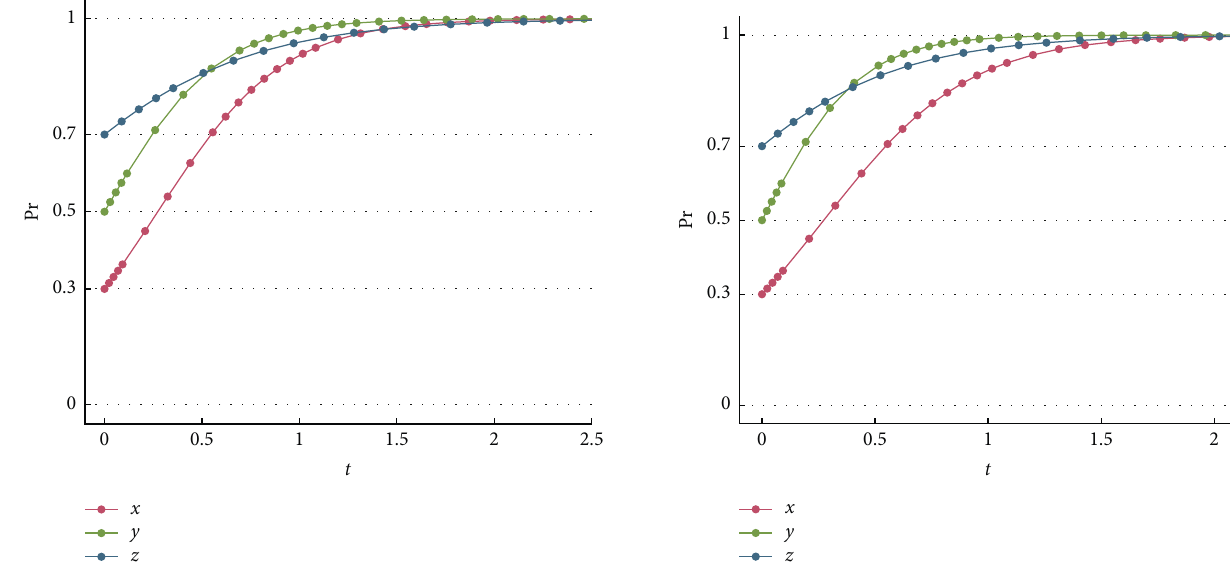
8 (1, 1, 1) with incentive-